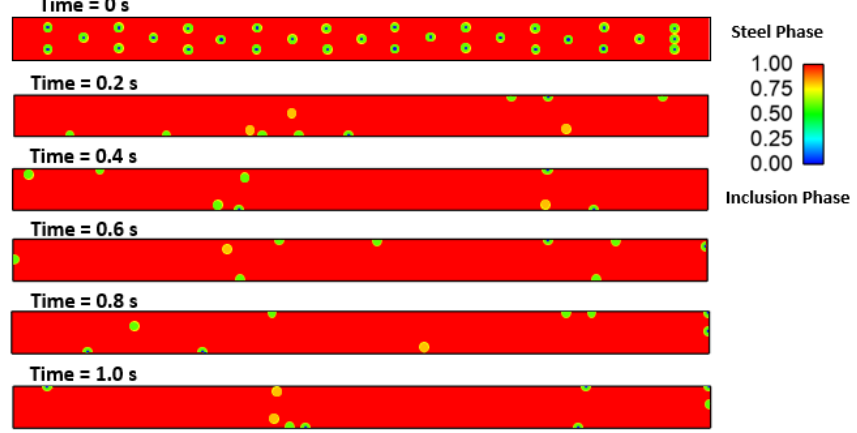
Figure 9. 4.31: Motion of alumina inclusion during solidification (initial temp: 1893 K, sulfur: 100 PPM).